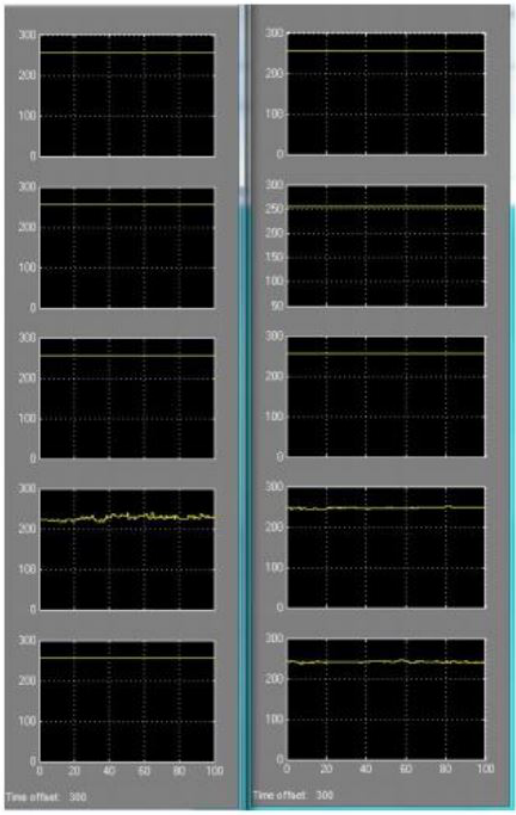
Figure 4: Voltage levels for idle state of the glove.